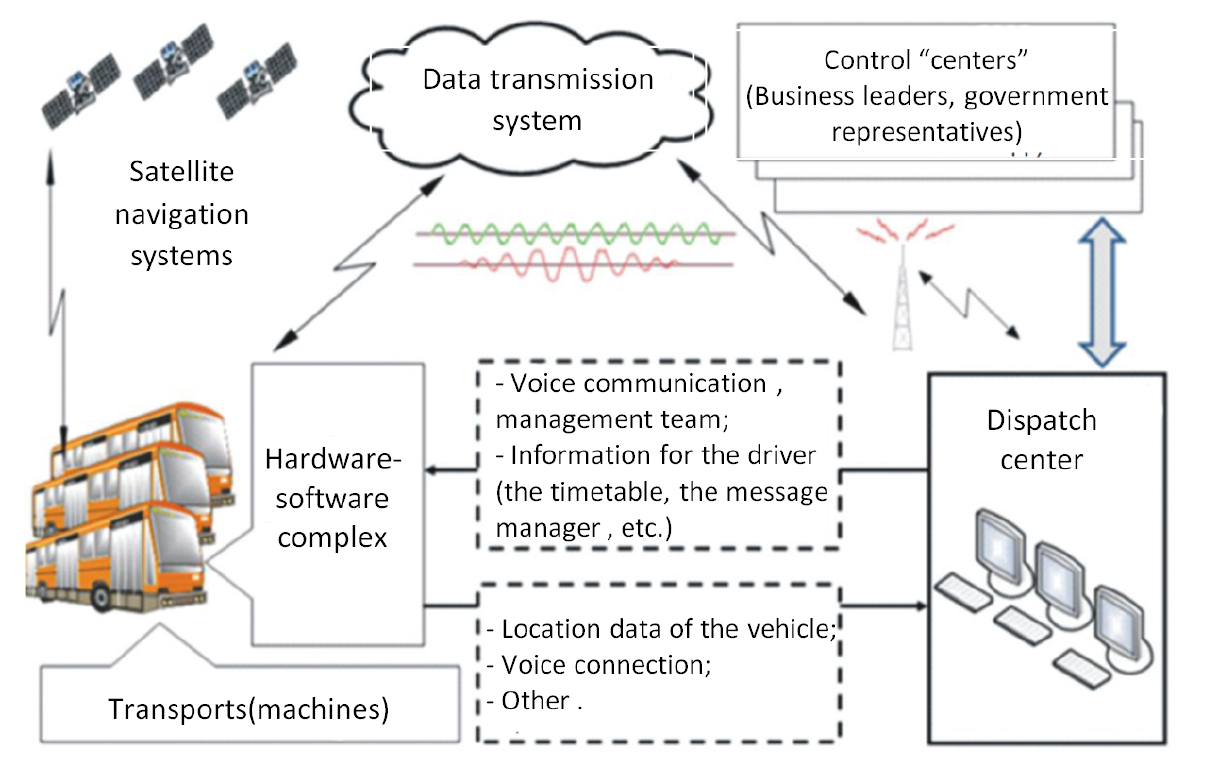
Figure 2. ANSDU work scheme, based on the satellite